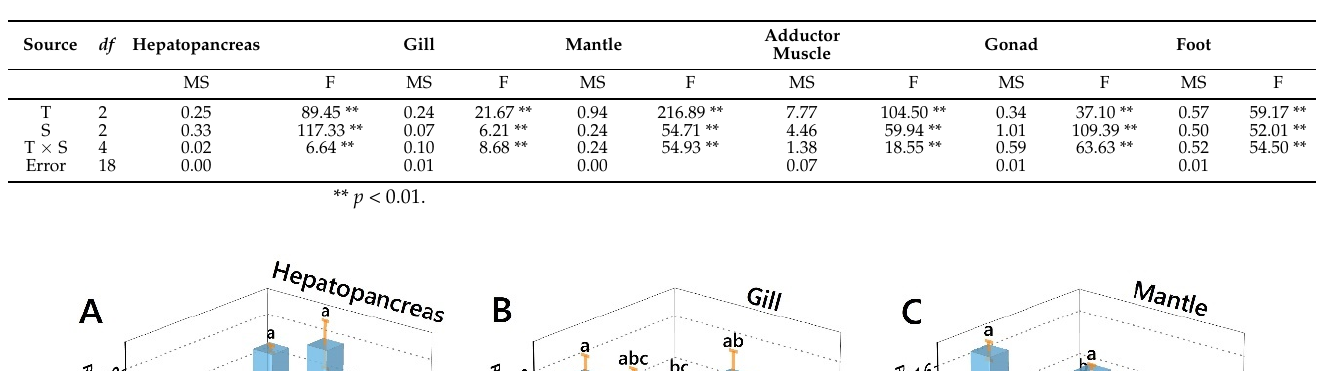
Table 5. MANOVA results using a generalized linear model for the main and interaction effects of temperature and salinity on the SOD relative expression level in Perna viridis .